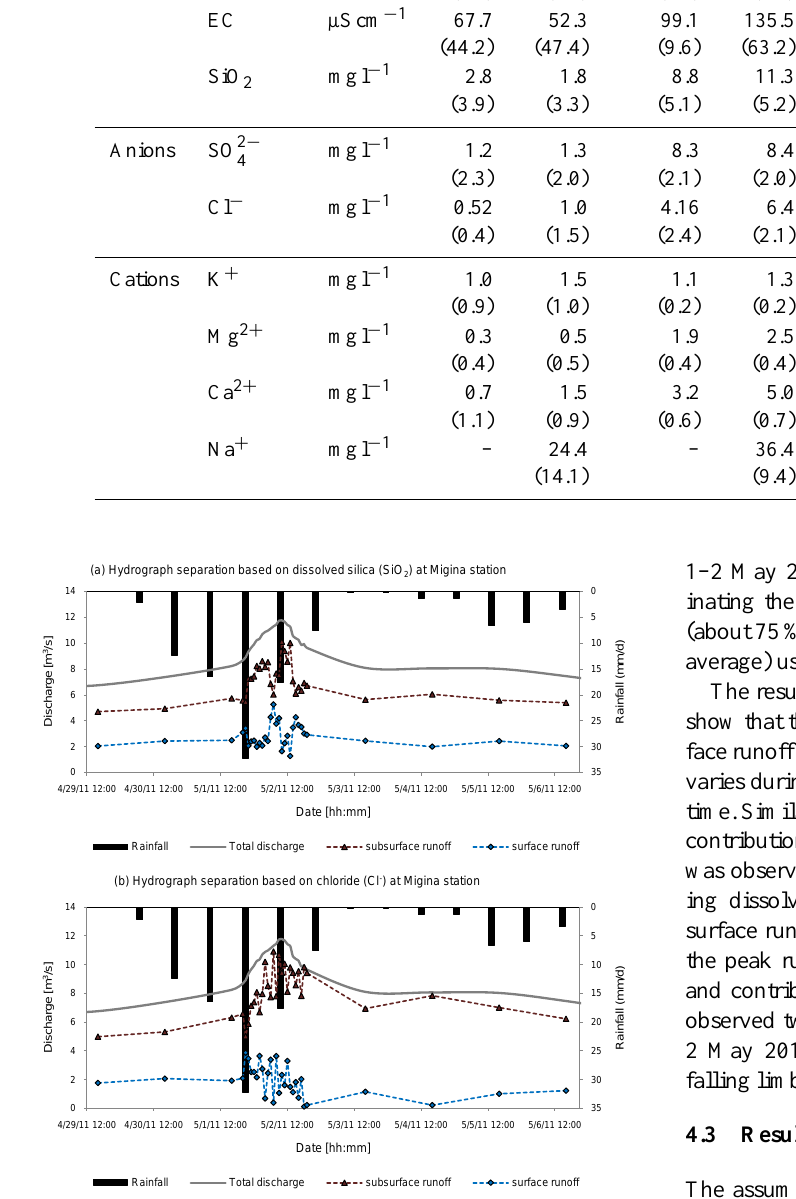
Figure 5 Two-component hydrograph separations based on dissolved silica (a) and chloride (b) for subsurface and surface runoff for event M3 (see Fig. 2b) investigated from 29 April to 6 May 2011 at Migina station.